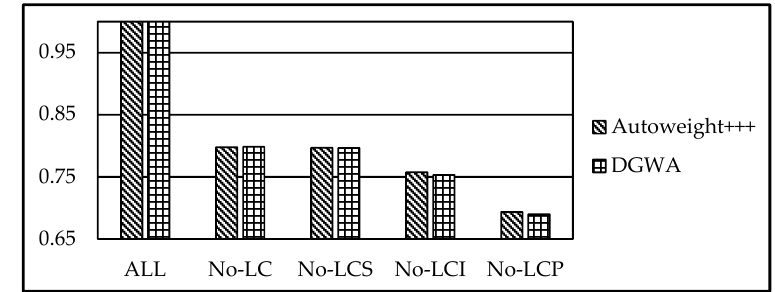
Figure 12. Comparison of methods Autoweight+++ and DGWA according to the results of F-Measure for different groups of test cases within Benchmark biblio ontology track.